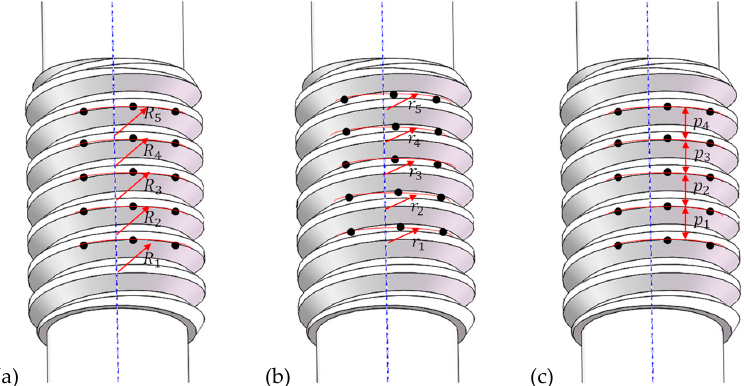
Figure 8. Measuring method for basis parameters of the threaded section: ( a ) outside diameter, ( b ) minor diameter, ( c ) pitch.